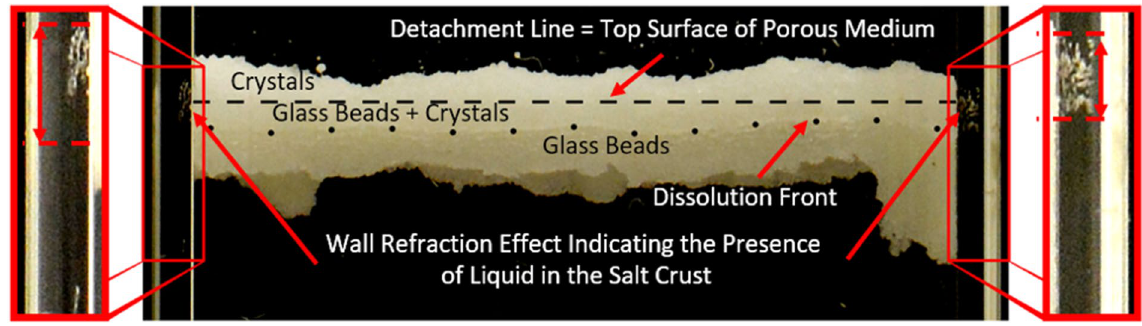
Figure 5. Observation of a greyish optical signal on the cell walls. The signal is visible on both sides when the crust moves upward, and indicates the presence of liquid water in the moving crust.